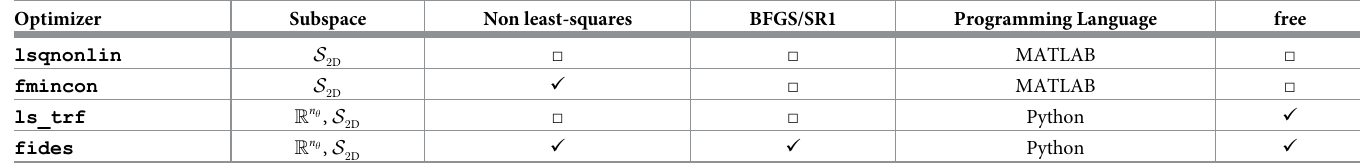
Table 1. Feature overview for different trust-region optimization implementations. The non least-squares column indicates whether the method is applicable to non least-squares problems. The free column indicates whether the implementation is freely available or proprietary